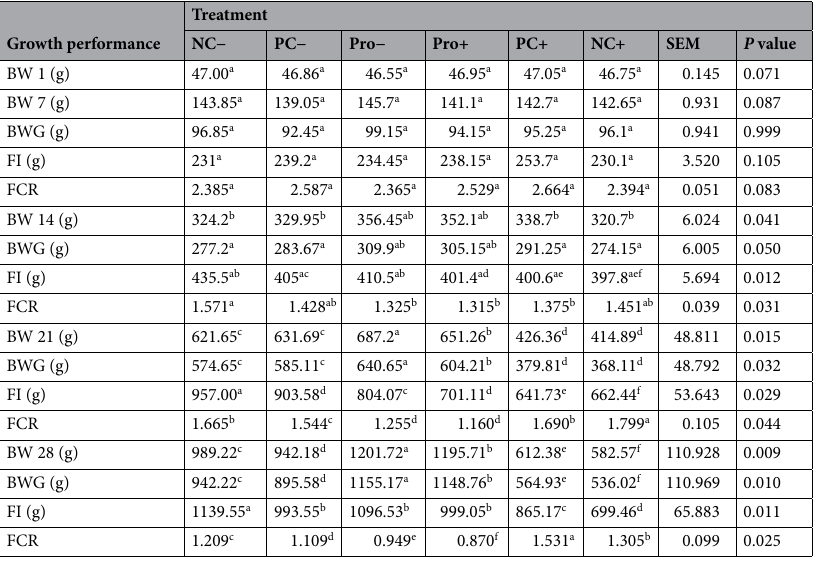
Table 1. Effects of probiotics supplementation on growth performance of Pasteurella multocida challenged broiler chickens. Values are means of two replicates and standard errors of means. Within each variable, values with the same superscript letter are not significantly different according to Duncan’s multiple range test (P > 0.05). NC−: unchallenged negative control; PC−: unchallenged positive control; Pro−: unchallenged probiotics control; Pro+: challenged probiotic control; PC+: challenged positive control; NC+: challenged negative control, BW−: body weight; BWG−: body weight gain; F−: feed intake; FCR: feed conversion ration.